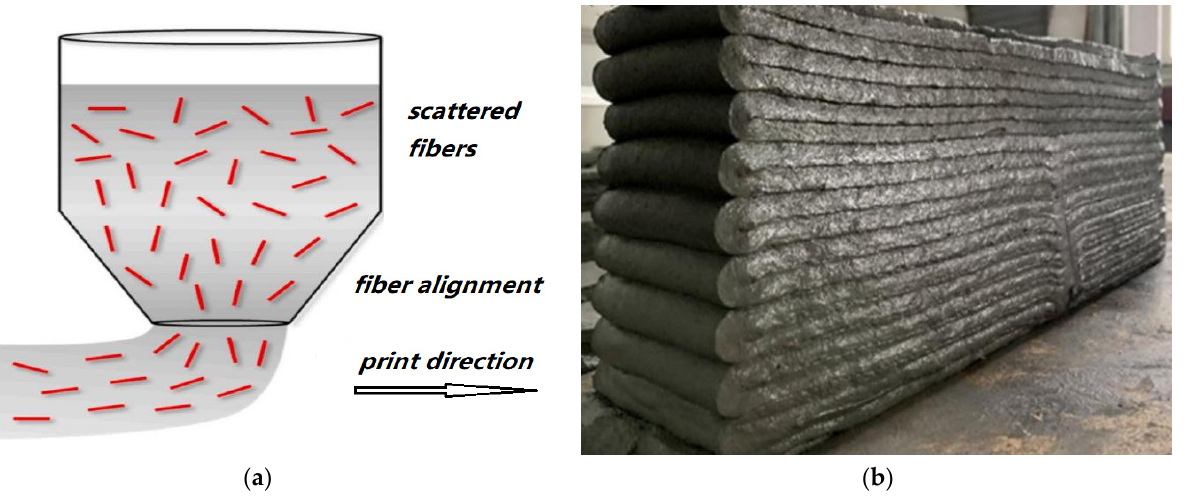
Figure 3. ( a ) Schematic drawing showing the admixture with fibers. Adapted from Nematollahi et al. [41]; licensed under CC BY 4.0 (open access). ( b ) Adhesion between the printing layers. Adapted with permission from [44], copyright 2021 Elsevier.